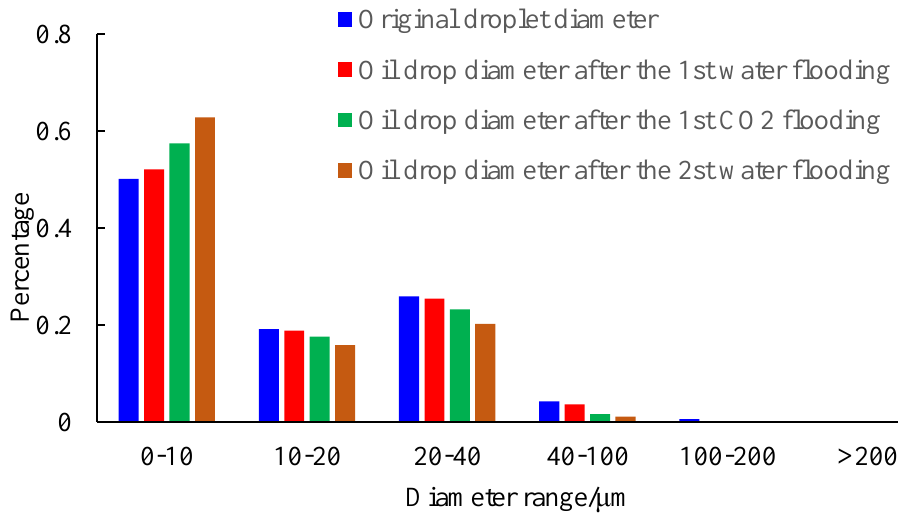
Figure 25. Distribution of the residual oil drop diameter of the Y53 – 89 core.